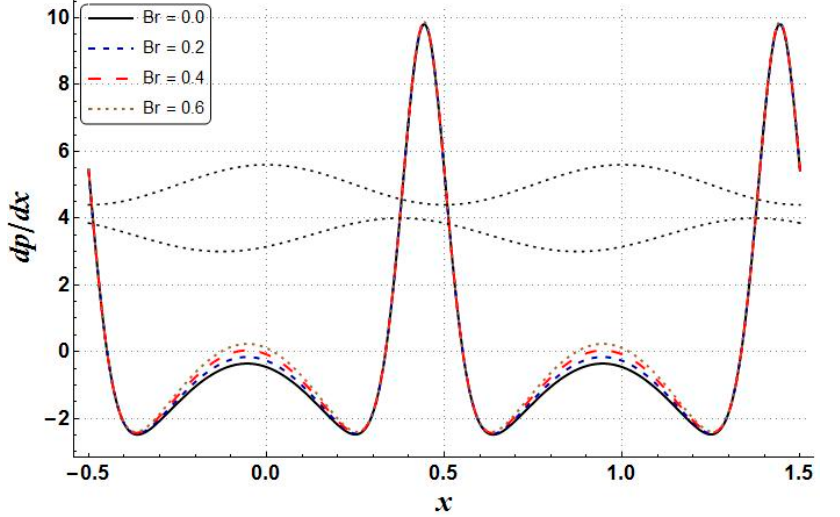
Figure 22. Influence on dp φ = 0.05, k = 2, a = 0.6, M = 1, d = 0.7, m = 1, b = 0.5, ∈ = 2, η =